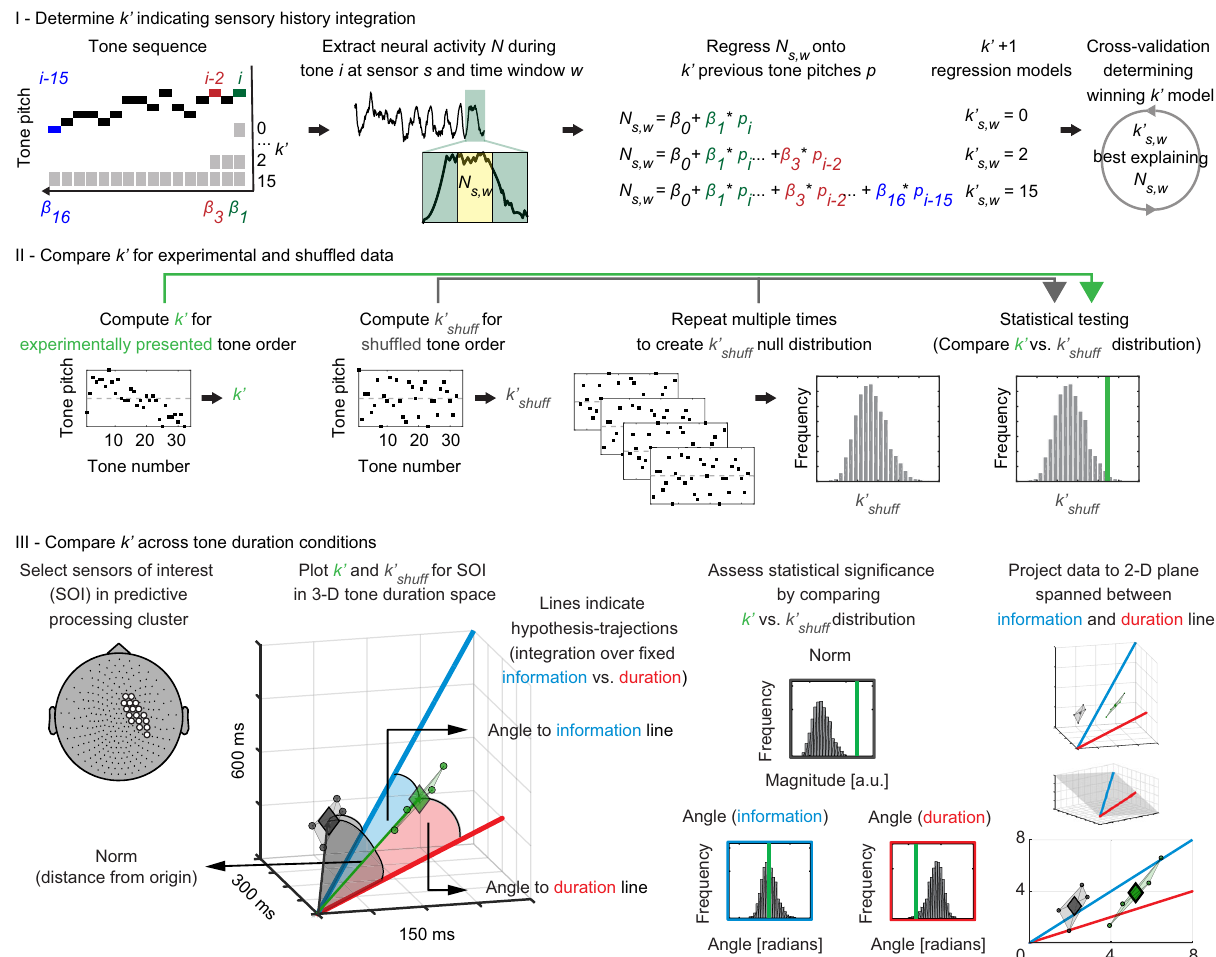
Fig. 4 Sensory history integration analysis schematic. I Non-baseline-corrected MEG activity, N s ; w for sensor s and time window w , in response to the i -th tone (16 ≤ i ≤ 32) is linearly regressed onto the current tone pitch ( p i ) and the pitch of k 0 preceding tones. The k 0 -value providing the best model fi t is determined by cross-validation, indicating the number of preceding tone pitches best explaining N s ; w . II k 0 -values from experimental data (green) are compared against a null distribution constructed by shuf fl ing tone order within each sequence ( k 0 shuff , gray). III k 0 -values computed for predictive processing clusters are compared across-tone duration conditions within a 3-D coordinate system (axes represent tone duration-speci fi c k 0 ). Sensor-wise k 0 values are shown as green dots, k 0 shuff -values are shown in gray. Diamonds represent the center of mass for the respective distribution (for visualization only). Blue (informational bottleneck) and red (temporal bottleneck) orientation lines indicate the hypothesis-derived location of k 0 -values. Vector norm (i.e., distance from origin) and angle (i.e., angle to respective orientation lines) for k 0 -values are statistically compared against the shuf fl ed null distribution (histograms). k 0 -values were additionally projected onto a 2-D plane de fi ned by the orientation p = 0.014; left middle histogram in Fig. 5a; data from the 100 – 150 ms time window showed a trend effect: mean angle: 0.061 ± 0.027, p = 0.065, Supplementary Fig. 5b). No signi fi cant